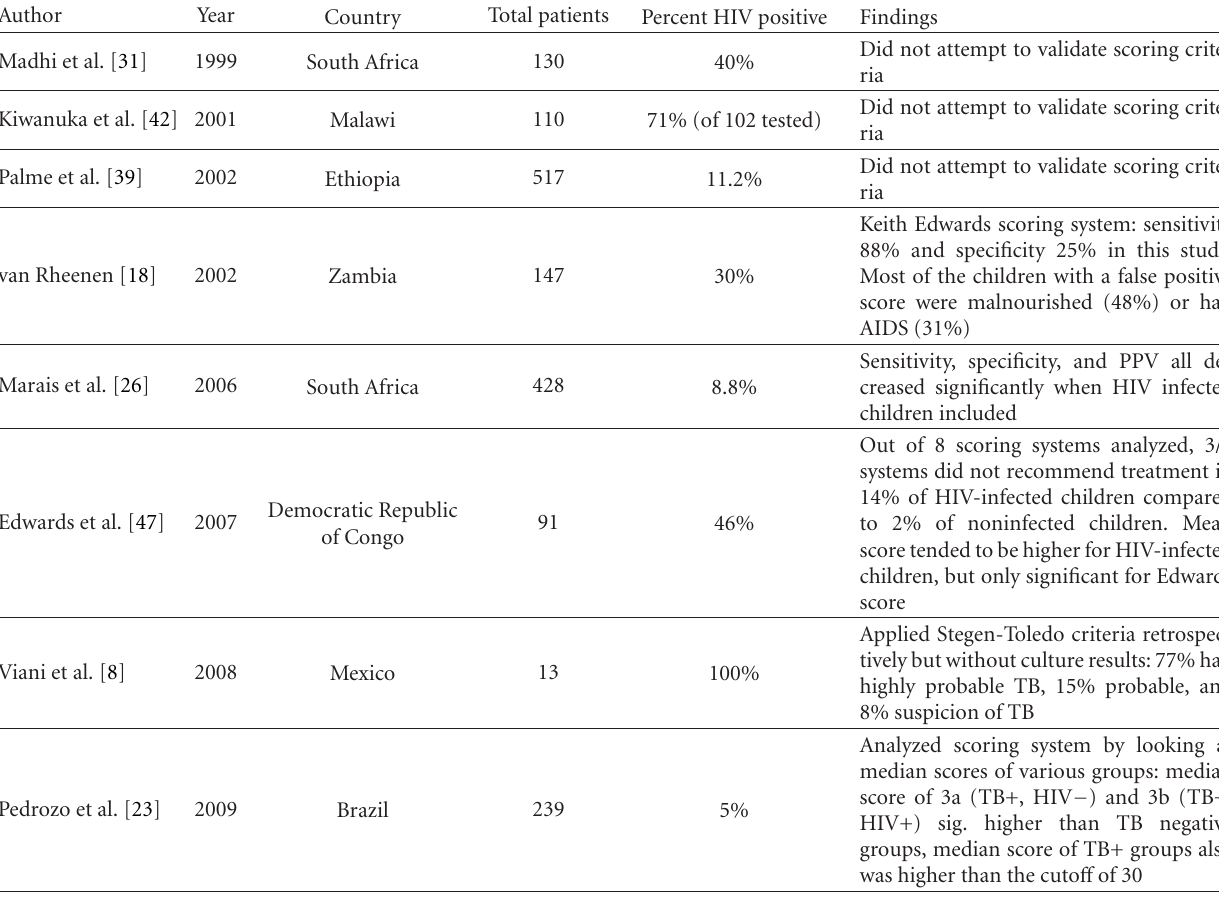
Table 6: Studies that specified how many patients were coinfected with